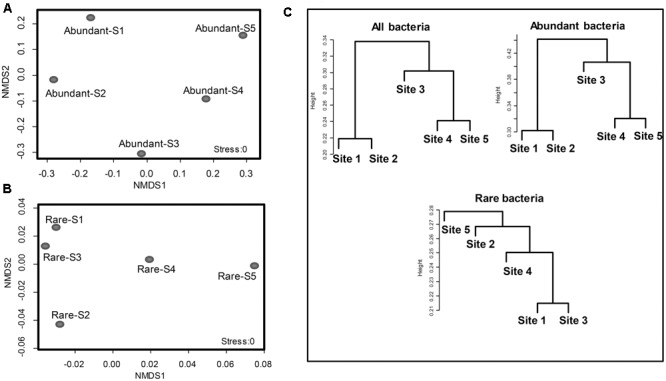
Clusters of abundant bacteria (>1%) and rare bacteria (<0.1%) as an indication of community structure. Non-metric multidimensional scaling (NMDS) of Bray-Curtis similarities of abundant (A) and rare (B) bacterial communities at the family level in the glacial foreland. (C) A dendrogram analysis of the communities of all bacteria, abundant bacteria and rare bacteria at the family level in the five glacial foreland soils.